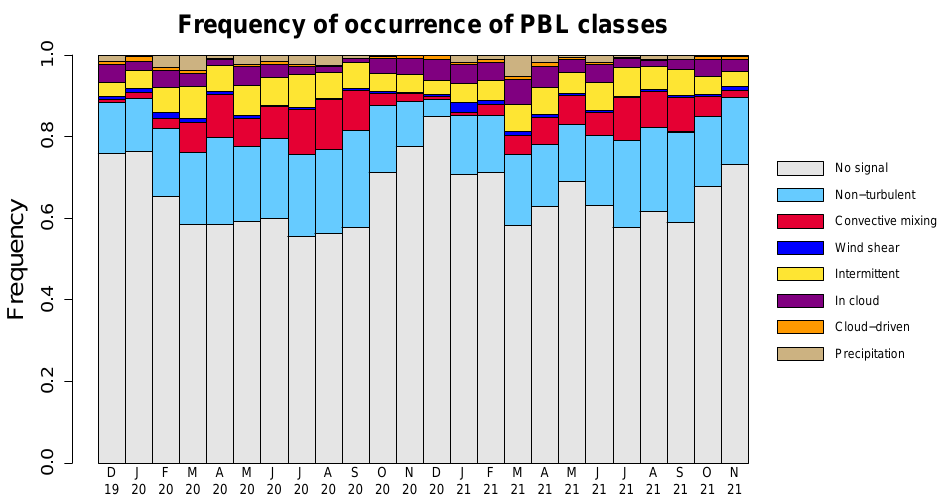
Figure 3. Frequency of occurrence of PBL classes for the December 2019–November 2021 period.